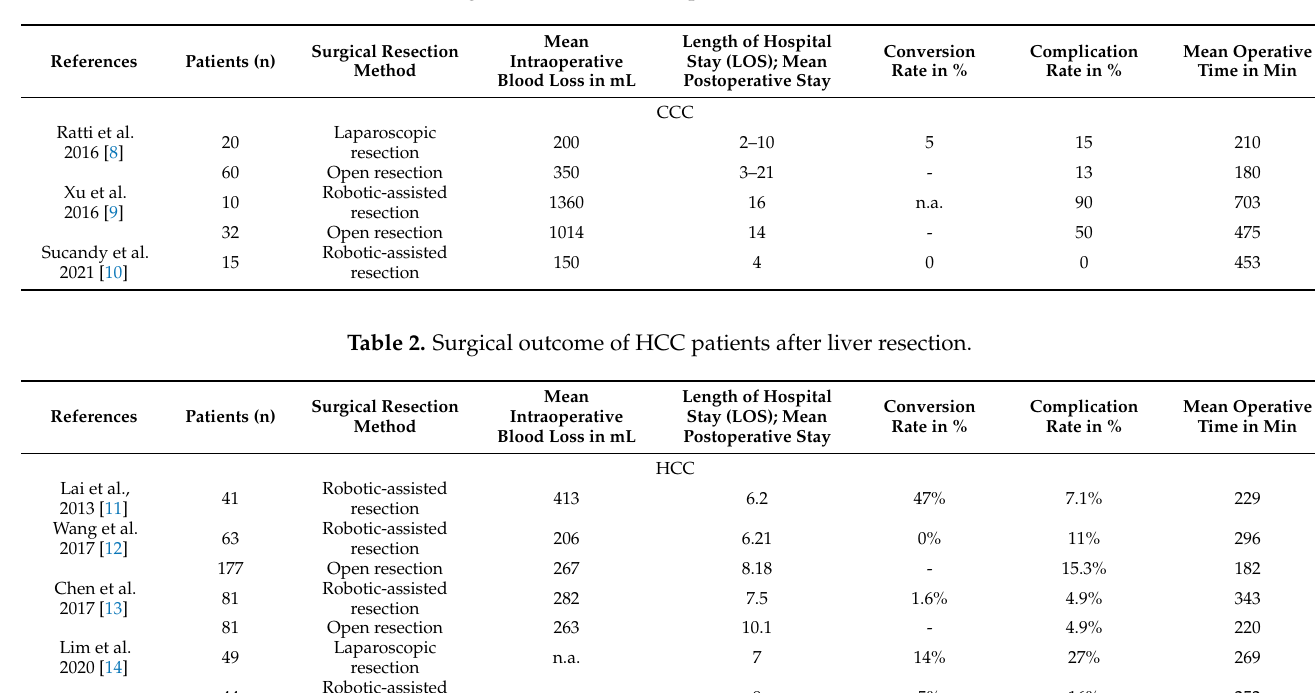
Table 1. Surgical outcome of CCC patients after liver resection.